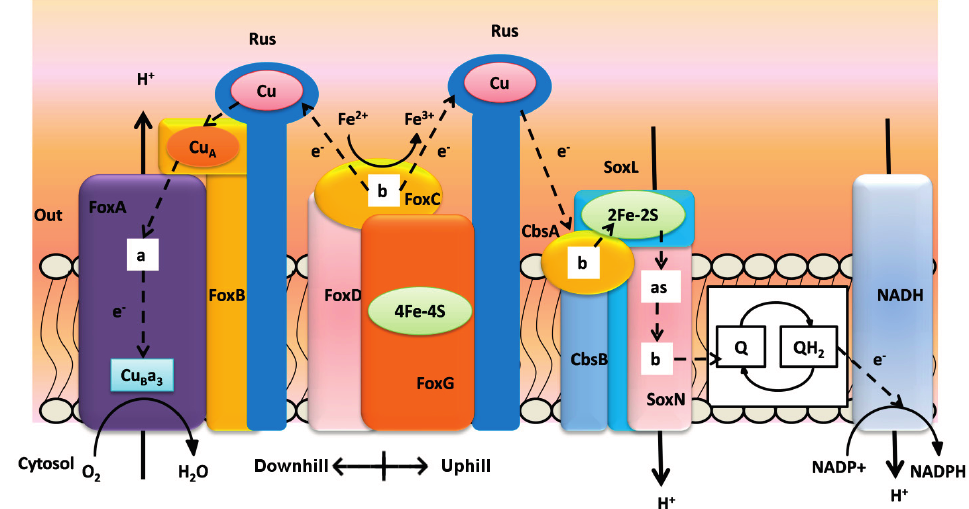
Figure 2. Proposed model for Fe(II) oxidation in M. sedula , based on